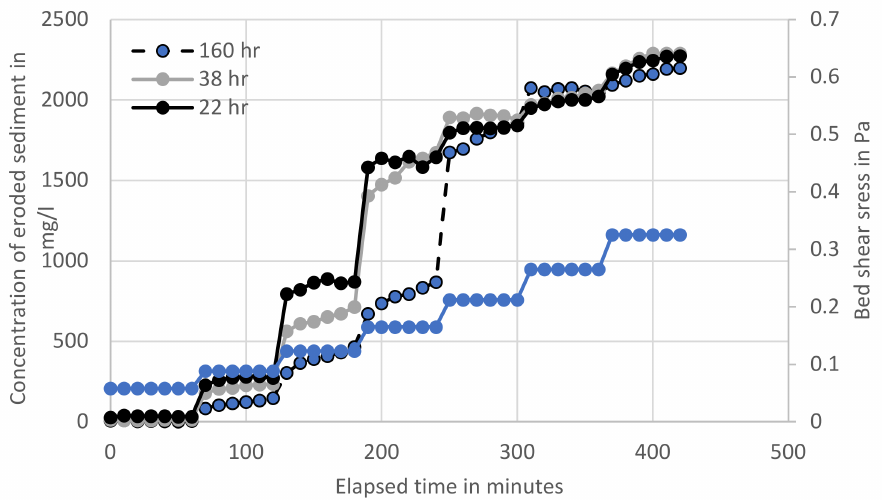
Figure 2. Results from the erosion